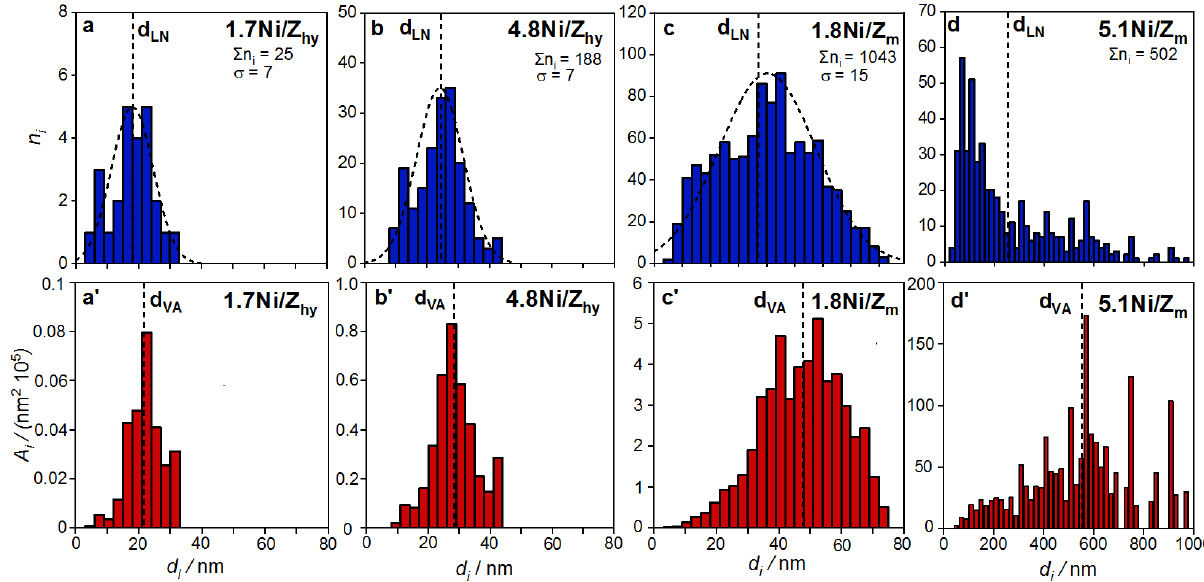
Figure 7. Ni-particle number (n i ) ( a – d ) and Ni-particle surface (A i = πn i d i2 ) ( a’ – d’ ) distributions as a function of Ni-particle diameters (d i ) for 1.7Ni/Z hy ( a , a’ ), 4.8Ni/Z hy ( b , b’ ), 1.8Ni/Z m ( c , c’ ) and 5.1Ni/Z m ( d , d’ ) samples. Dotted lines identify the length-number mean diameter (d LN ) or volume-area mean diameter (d VA ) values; Σn i stands for the total number of Ni particles from FESEM images. For samples showing a normal distribution curve of Ni particles size, the curve and the corresponding standard deviation σ are also reported.